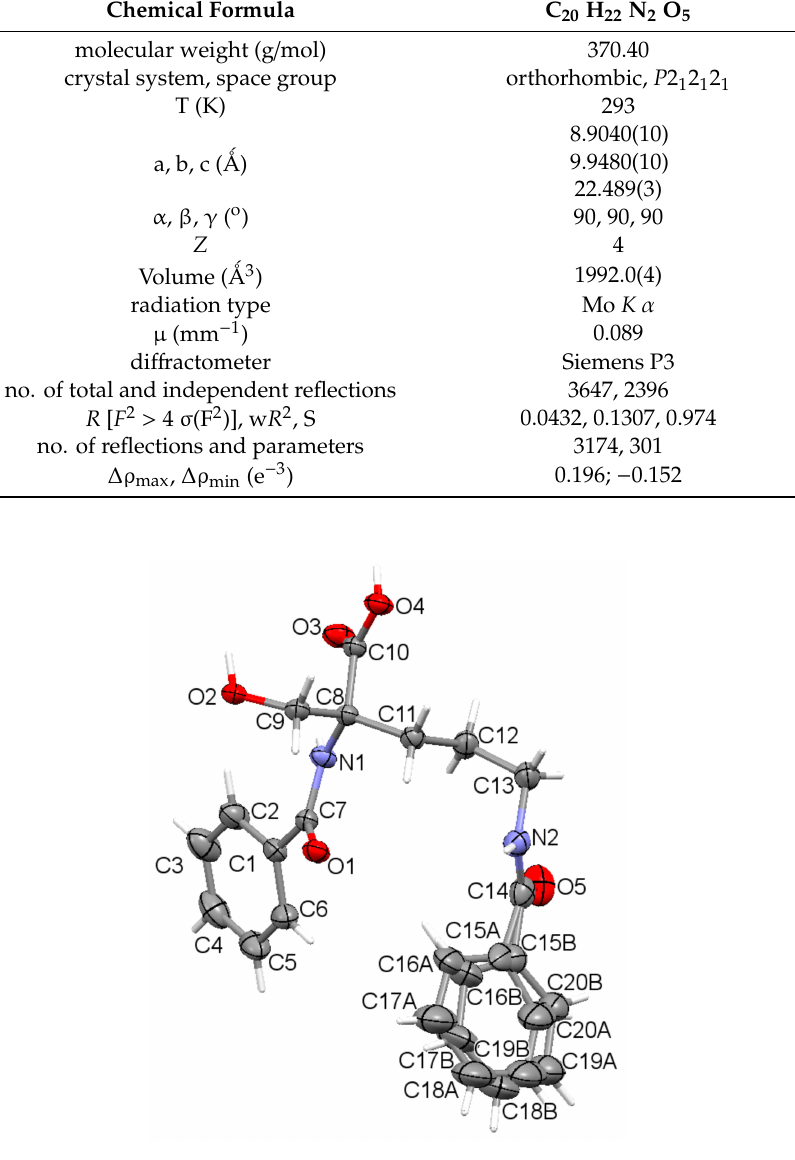
Figure 1. The asymmetric unit of the title compound 1 , showing disorder of the phenyl ring (C15 to C20) over two sites, with displacement ellipsoids for non-H atoms drawn at the 30% probability level, with the atom labeling. Hydrogen atoms are shown by spheres of arbitrary